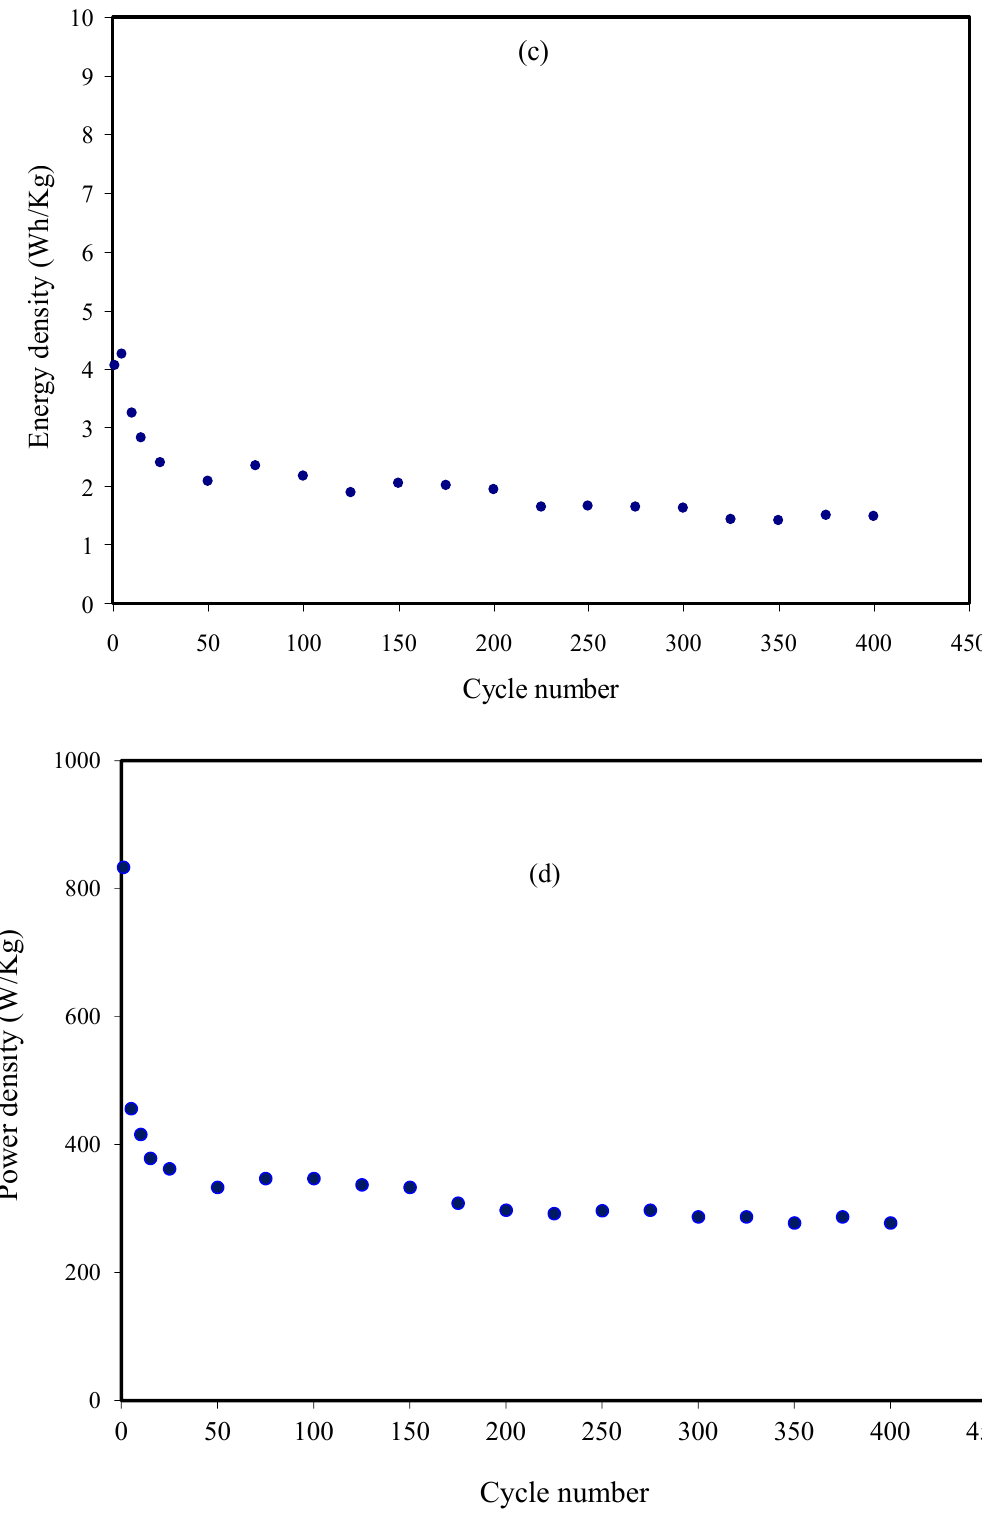
Figure 13. EDLC parameters of ( a ) specific capacitance ( C s ), ( b ) equivalence series resistance ( ESR ), ( c ) energy density ( E d ), and ( d ) power density ( P d ) versus cycle number.